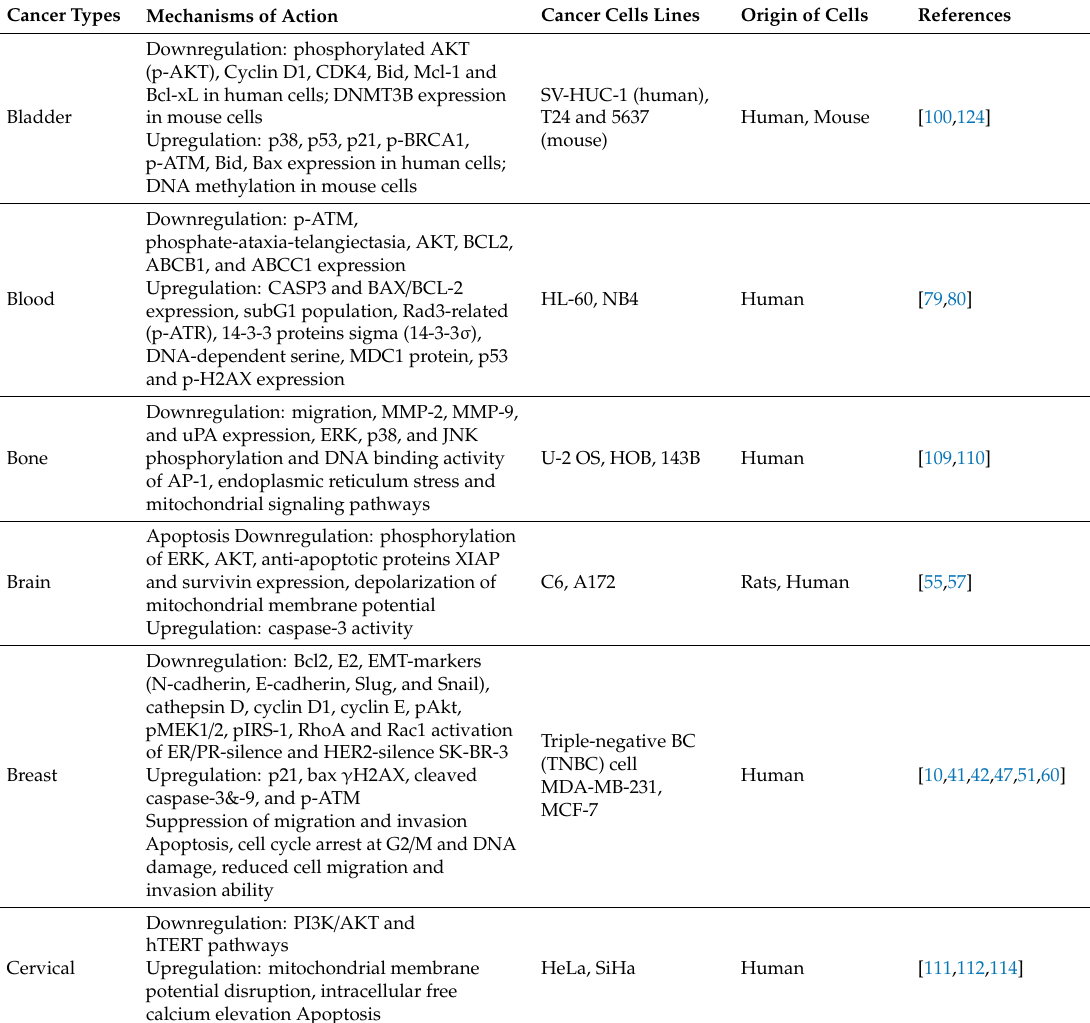
Table 1. Studies of anticancer activities of kaempferol in